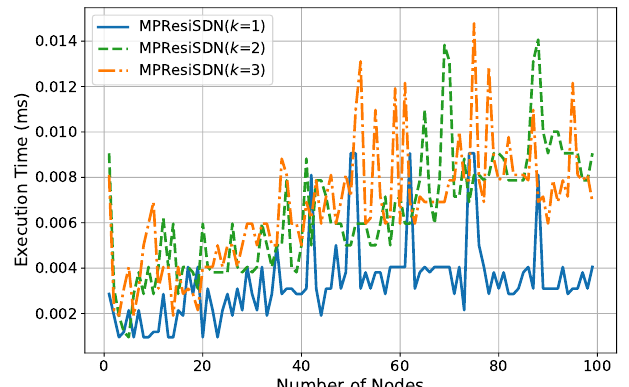
Figure 11. Evaluation of execution time using different k values and network